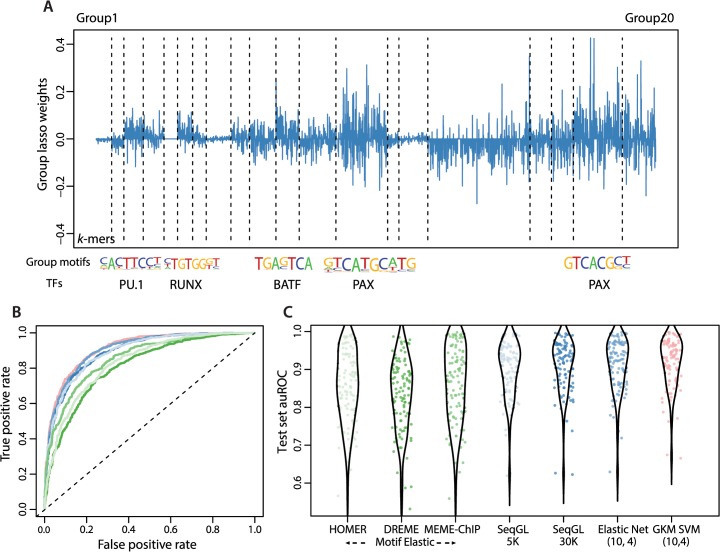
SeqGL performs significantly better than traditional motif discovery methods across different settings.(A) Plot showing the k-mer weight inferred group lasso regularized logistic regression for PAX5 ChIP-seq in GM12878 cell line. A number of groups are uniformly set to 0 (Group 5), while other groups are either significantly predictive of peaks or flanks (Group 3 and Group 2 respectively). Motifs identified for groups that are strongly predictive of peaks and the corresponding TFs are also shown. (B) PAX5 ChIP-seq auROC on the test set comparing the discriminative performance of SeqGL with motif finding tools and k-mer methods. The different colors correspond to the colors in Fig 2C. (C) Plots showing auROCs on test sets for 105 ChIP-seq experiments using different tools and settings. Three different settings were used for the motif finding tools HOMER, DREME and HOMER (see S1 Fig). ‘Best motif’ uses the highest-ranking motif from each method, as defined by the p-value; ‘Max motif’ uses the motif with maximum log odds score in each example; and ‘Motif elastic’ uses elastic net logistic regression across all motifs determined by the respective method. Only the ‘Motif elastic’ methods are shown in the performance plots, since they outperform the ‘Best motif” and ‘Max motif” methods. ‘SeqGL and other k-mer methods significantly outperform the different motif finding tools across all settings (Wilcoxon rank sum p-values < 7e-3). gkm-SVM performs marginally (but not significantly) better compared to SeqGL with 5K top discriminative features (Wilcoxon rank sum p-value = 0.06); SeqGL using a larger feature set (30K) gives identical performance to gkm-SVM (no difference in the distribution of auROC scores based on a Wilcoxon rank sum test, using p-value < 0.05 for our threshold of significance). Furthermore, the elastic-net regressor on the full SeqGL feature space using 10-mers with 3 wildcards (similar to settings used by gkm-SVM) also yields identical performance. While the discriminative accuracy is comparable, unlike other k-mer methods, SeqGL identifies multiple distinct DNA binding signals from the same ChIP-seq experiment (S3 Table).